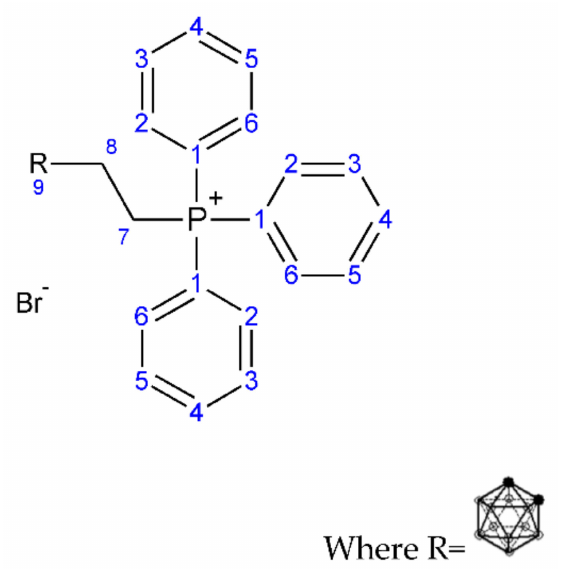
Figure 5. Structure of (3-carboranylpropyl) (triphenyl phosphonium) bromide (2). 1 H NMR: (3-carboranylpropyl) (triphenyl phosphonium) bromide (2); (AV400